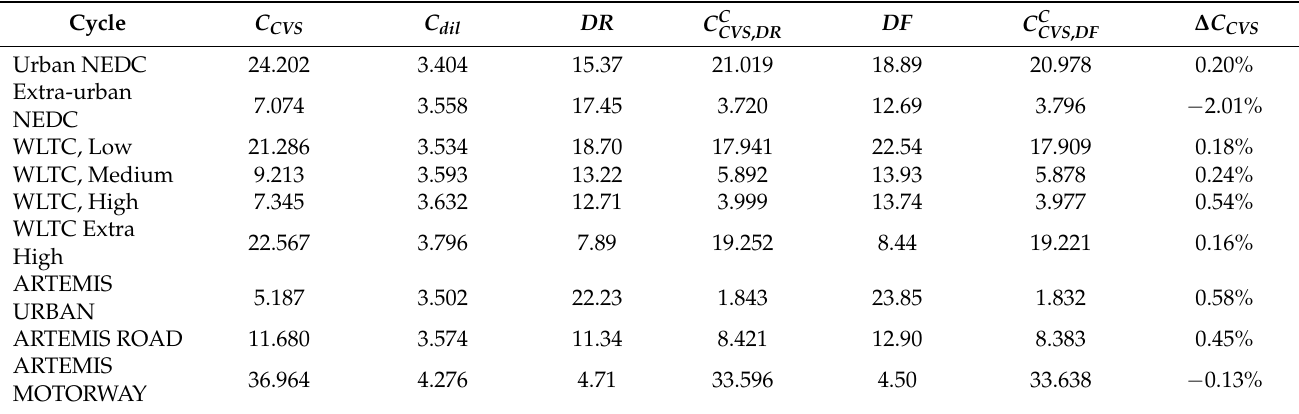
Table A9. The C CVS,corr calculated based on Equations (5) and (21) for Euro 6 NEDC vehicle with SI engine, THC concentration